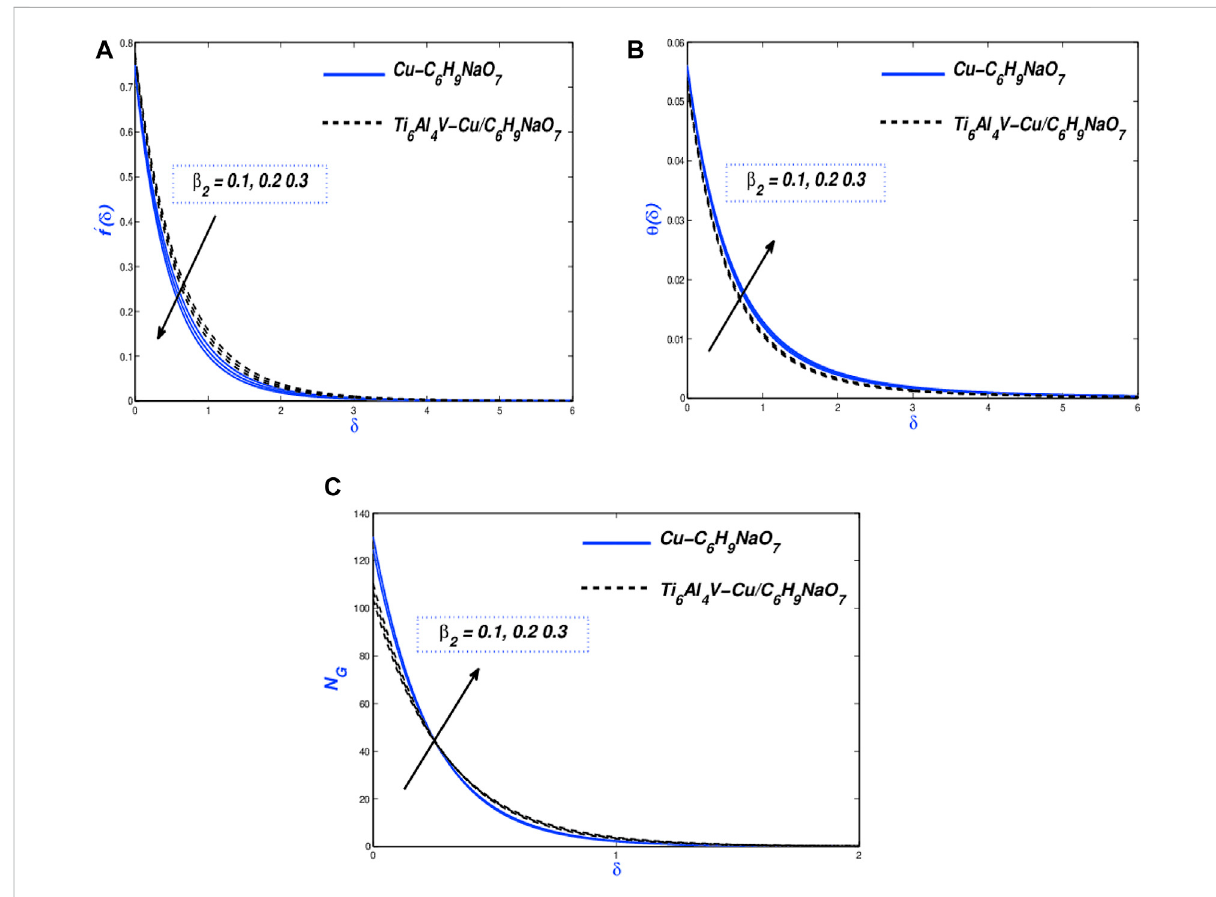
Figure 5B. This effect is caused by the support of the stretching surface in overcoming the material yield stress dominance. In addition, temperature-dependent control various levels. As the Powell-Eyring effect is augmented, the molecular bond is disrupted, and the particles are allowed to move freely. As a result, Powell-Eyring ‘ s term has a minimal rising effect Figure 5B. In Figure 5C, the entropy variation is plotted versus the Powell-Eyring term. Under the increment of β , the curves show different patterns. It illustrates an 2 augmentation near the stretching wall, while a modest reduction is detected at a distance from it. The reason for this illustration is that when a large temperature gradient occurs at the surface, more entropy is produced, causing higher oscillations in nanoparticle mobility.